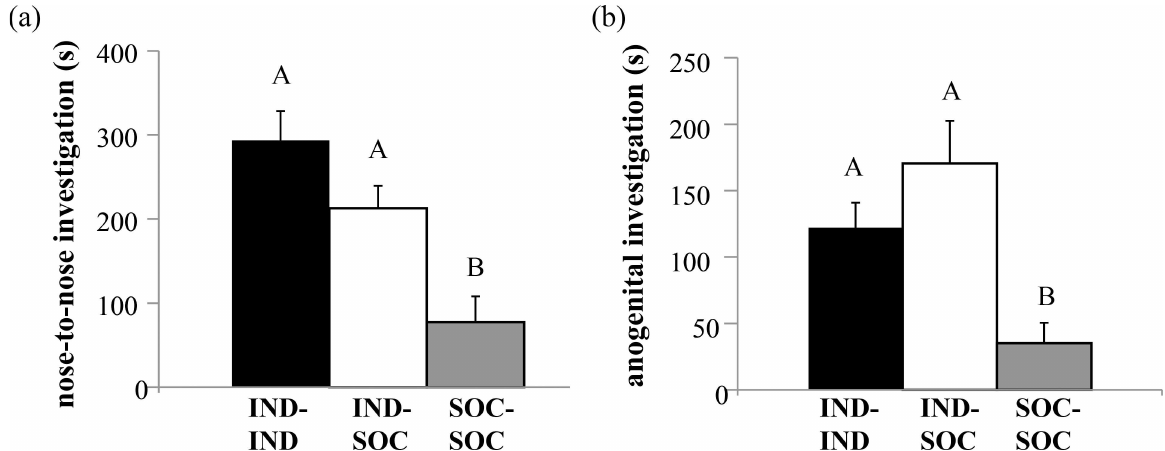
Fig 5. Social history influenced the total durations of social investigation behaviors performed by pairs of male mice. (a) Nose-to-nose investigation exhibitedby pairs of male mice with different social histories. (b) Anogenitalinvestigation exhibitedby pairs of male mice with different social histories. Bar heightsrepresent means ± S.E.M; bars with different letters are statistically different (Kruskal-Wallis tests with Bonferroni post-hoc tests, p < 0.05). IND = individually housedmale; SOC = sociallyhousedmale. See methodsfor additionaldetails